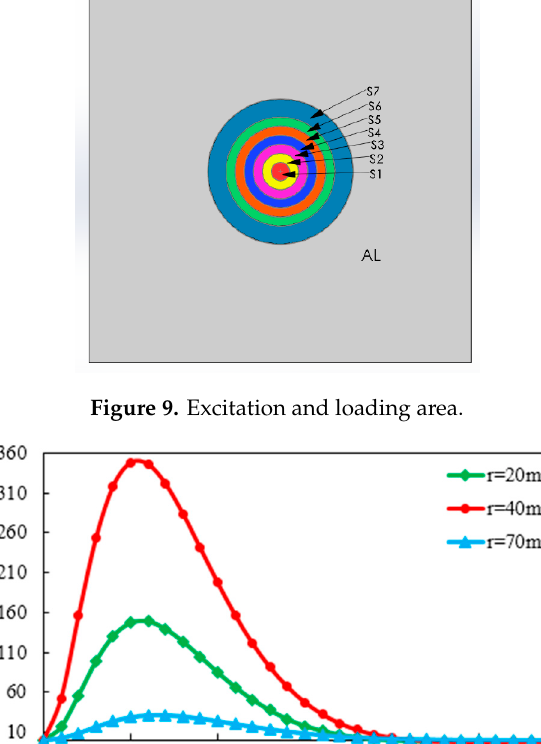
Figure 10. Relationship between force and time.